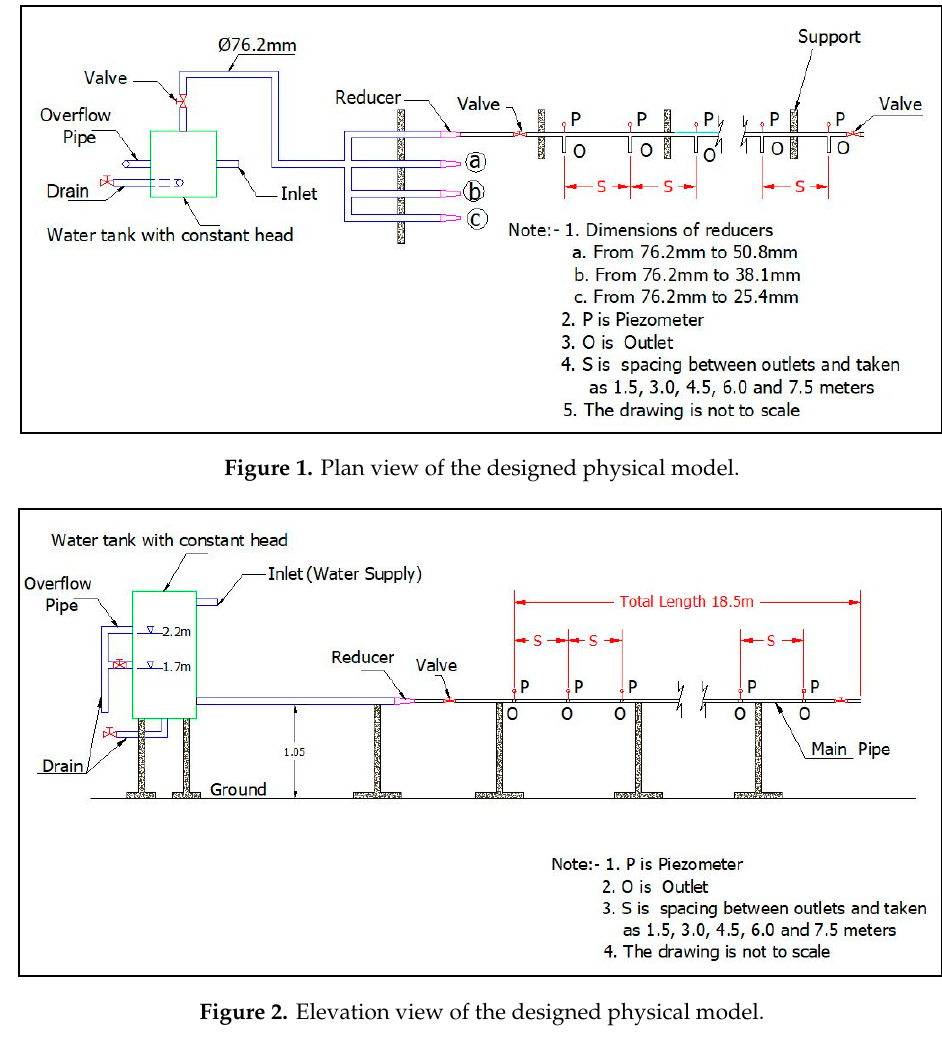
Figure 2. Elevation view of the designed physical model.